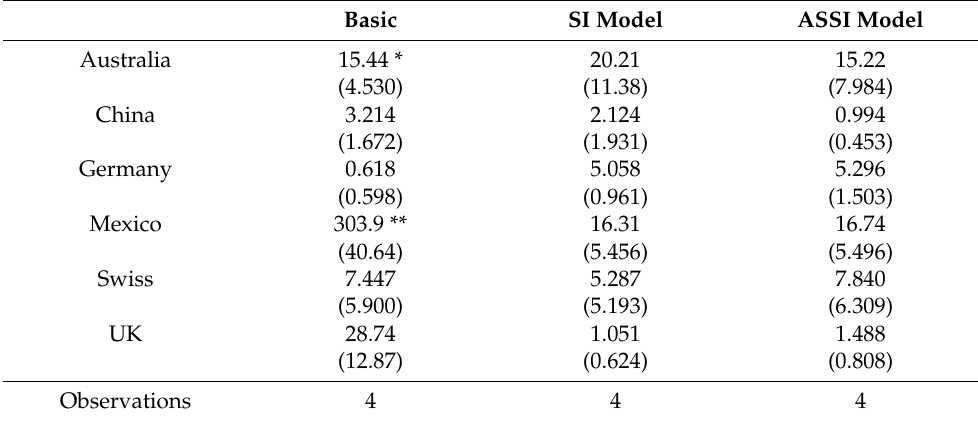
Table 6. Prediction Performance